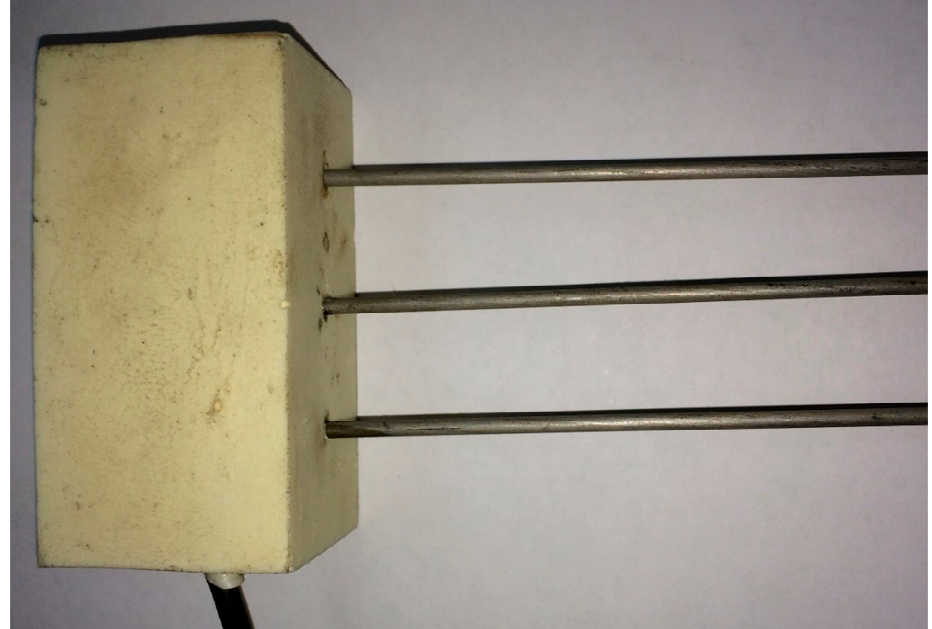
Figure 2. Time-domain reflectometry probe used in this study, the middle rod is connected to the positive wire of the coaxial cable, and the outer rods are connected to the ground wire of the coaxial cable.